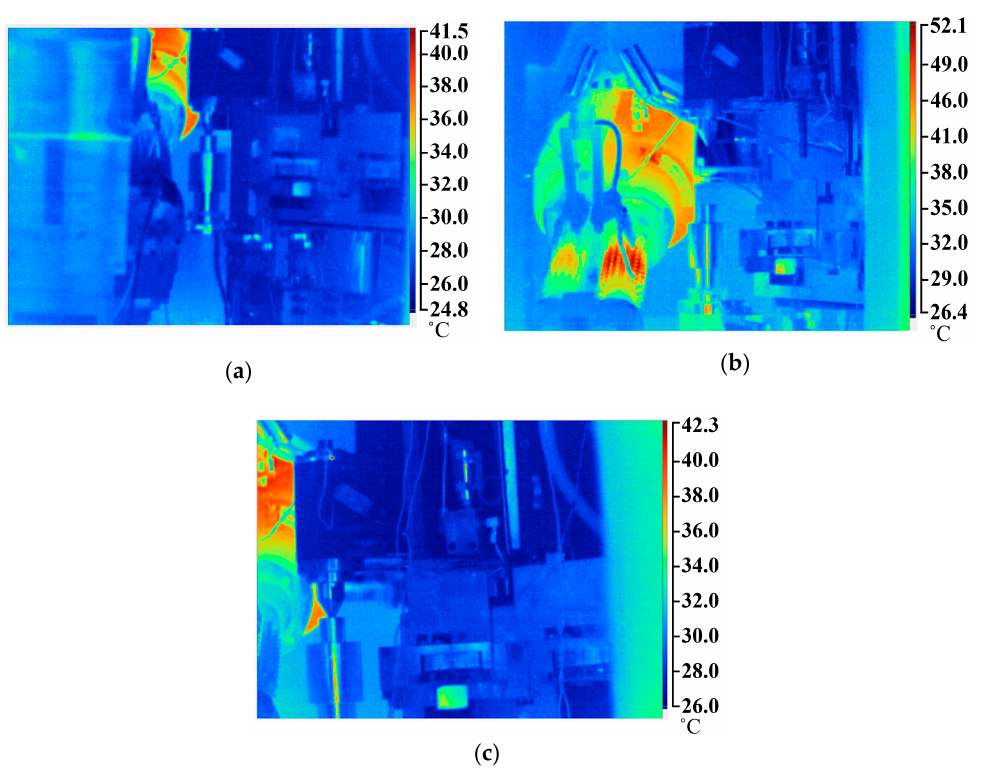
Figure 7. Infrared thermogram under: ( a ) original condition; ( b ) optimization with maximum EE sp and ( c ) optimization with maximum EE sp , maximum MRR , and minimum T avg .